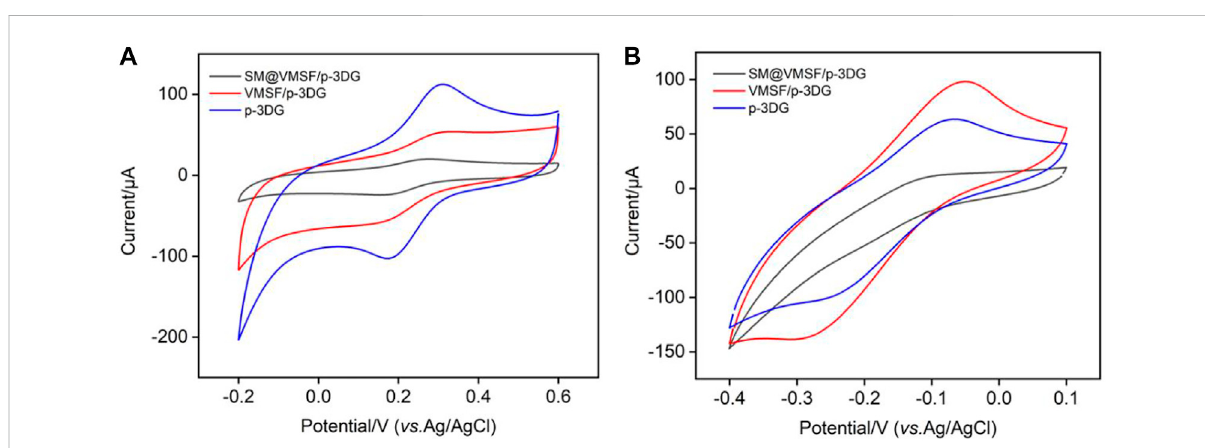
signal ampli fi cation effect of VMSF nanochannels. Figure 5B displays the corresponding DPV curves obtained on different electrodes. The p-3DG electrode exhibits lower oxidation potential compared with 3DG, proving the electrocatalytic